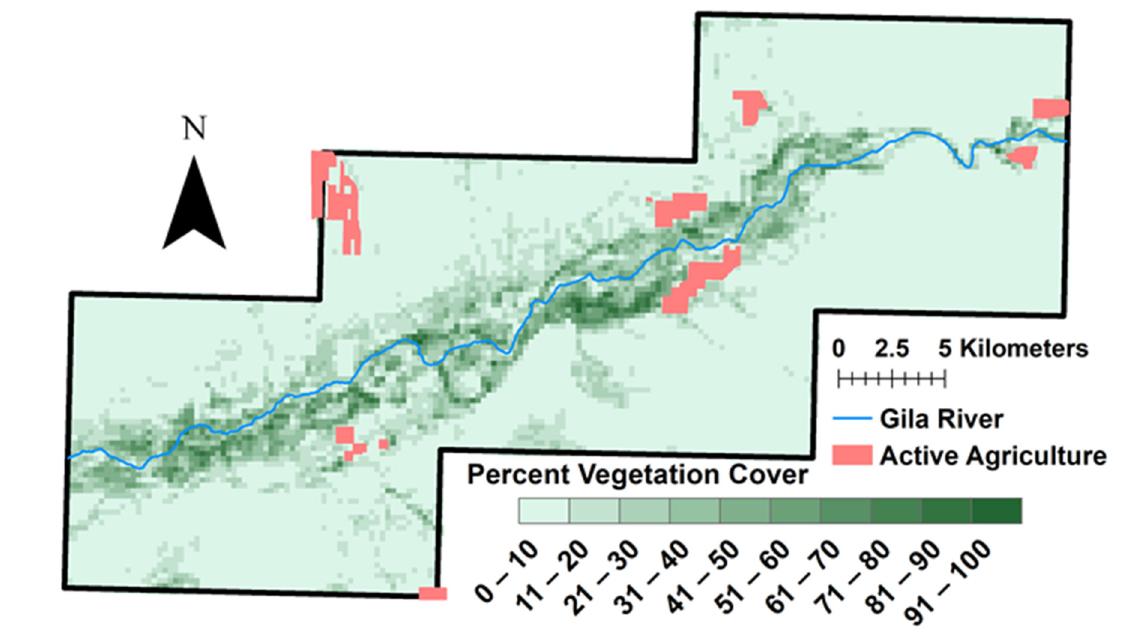
Figure A1. Percent Vegetation Cover 1996. 250 m tessellation of vegetation cover in 1996. Areas with less cover are shown in light green and areas with greater cover are shown in dark green. Areas of active agriculture are shown in pink.